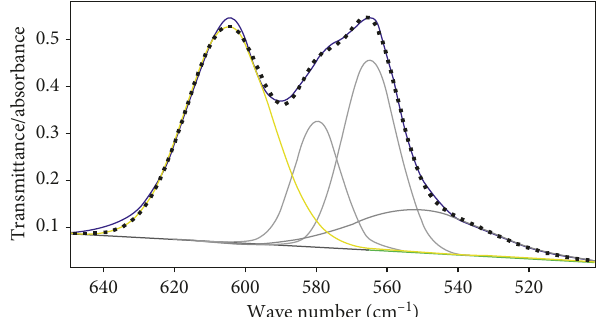
Figure 7: Original spectrum in the ] 4PO 4 area (dark blue line) recovered by the Gaussian sum fitting (dotted-black line) and the 4 individual peaks beneath (full lines). The peak used to compute the Crystallinity parameter is 604cm − 1 (yellow line).